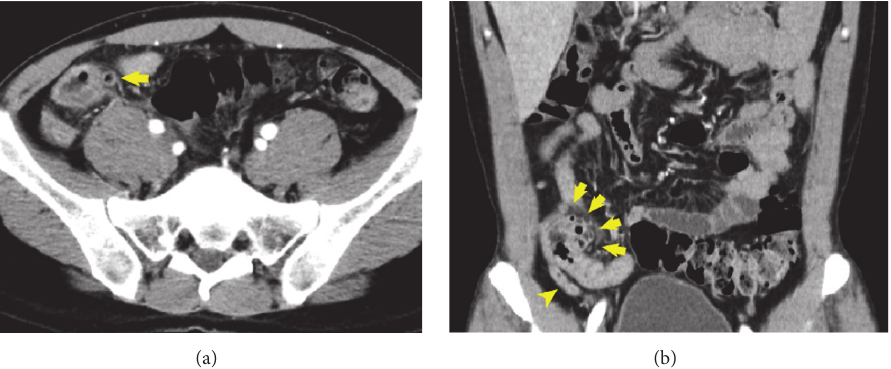
Figure 1: Computed tomography revealed diverticula sequentially located in the wall thickening terminal ileum (arrows); surrounding abdominal fat was developing high density suggesting inflammation. The appendix was not swollen (arrow head).